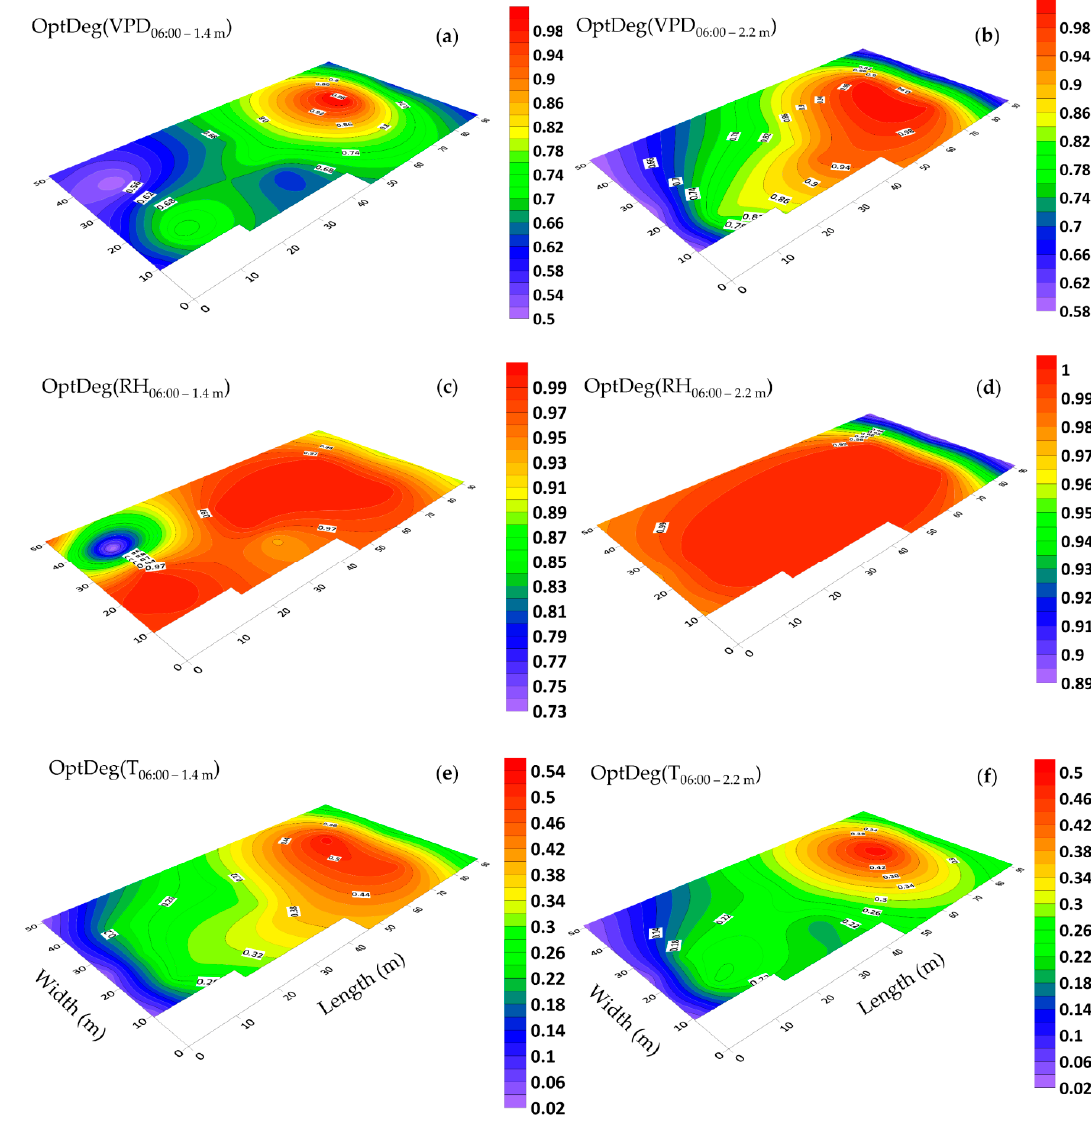
Figure 13. Optimality degrees range and distribution on a horizontal plane at 06:00 in 1.4 m and 2.2 m elevations on 10 January 2018. OptDeg(VPD) at 1.4 m ( a ) and 2.2 m ( b ); OptDeg(RH) at 1.4 m ( c ) and 2.2 m ( d ); and, OptDeg(T) at 1.4 m ( e ) and 2.2 m ( f